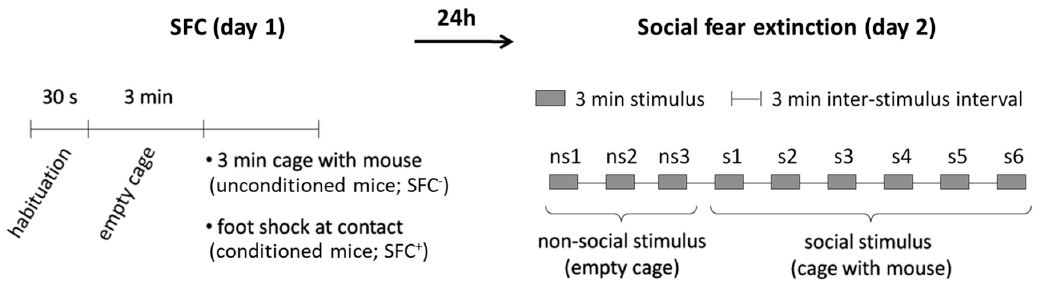
Figure 1. Schematic representation of the social fear conditioning (SFC) paradigm. During SFC on day 1, mice were placed in the conditioning chamber and, after a 30-s habituation period, an empty wire mesh cage was placed inside as a non-social stimulus. After 3 min, the empty cage was replaced by an identical cage containing an unfamiliar mouse. Unconditioned mice (SFC − ) were allowed to investigate this social stimulus for 3 min. Conditioned mice (SFC + ) were given a mild electric foot shock each time they investigated the social stimulus. During social fear extinction on day 2, mice were exposed in their home cages to three non-social stimuli, followed by exposure to six unfamiliar social stimuli. Anisomycin or vehicle were administered intraperitoneally either 20 min before, immediately after, 4 h, 6 h, or 8 h after SFC on day 1.